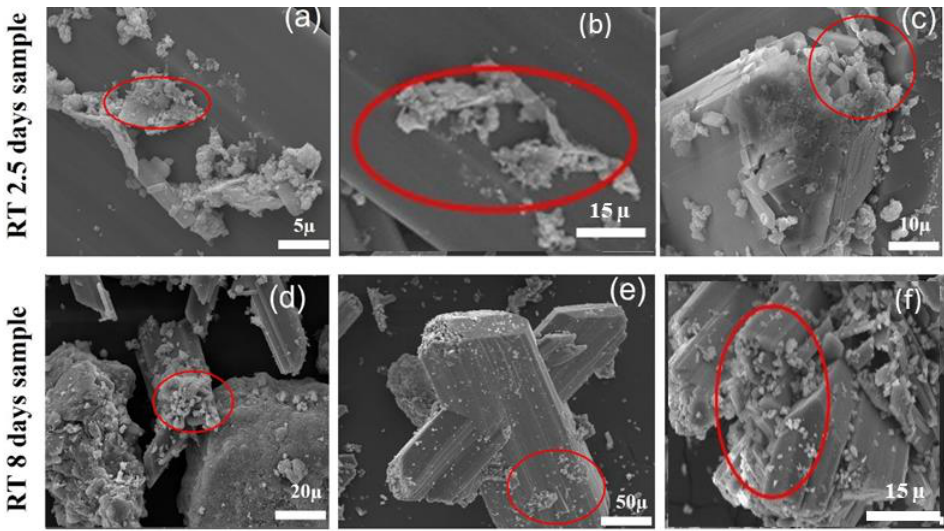
Figure 10. ( a – f ). View of magnified pyrite surface from samples originating from bioreactor solutions from 2.5- and 8-days residence time tests at 500 RPM, 1 L/min air flow, 35 ◦ C, and 6 wt% solids conditions showing the relative fraction of species that are generally identified with biooxidation of pyrite.